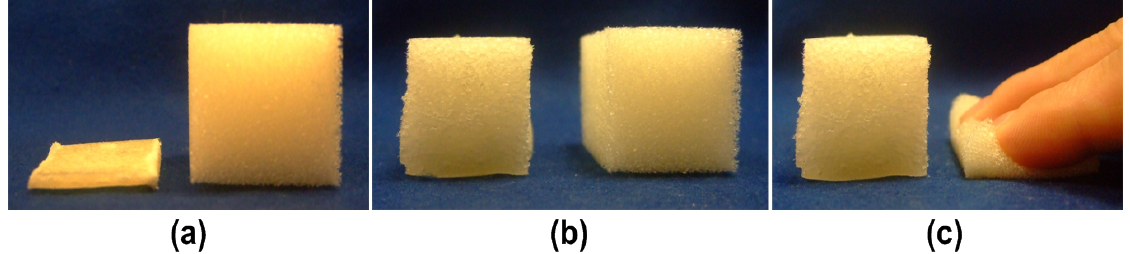
Figure 20. The SME in an elastic sponge–PW hybrid. The sample is pure sponge for comparison. ( a ) After programming (being compressed above the melting temperature of PW); ( b ) after heating to above the melting temperature of PW; and ( c ) high elasticity in the sponge (right